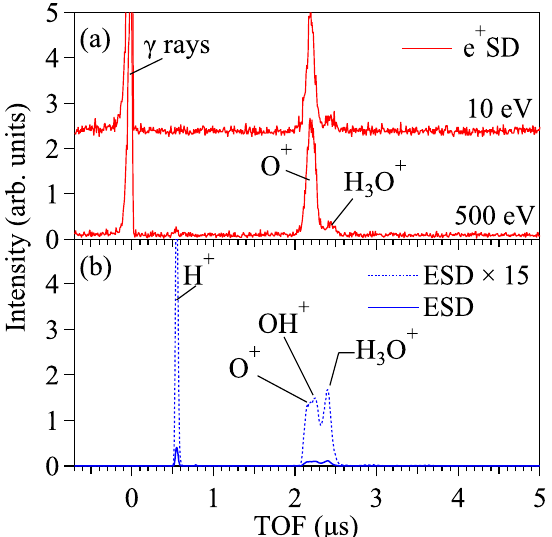
Figure 3. TOF spectra of the ions desorbed from water chemisorbed on a TiO 2 (110) surface caused by ( a ) positron bombardment at incident energies of 10 eV and 500 eV and TOF spectrum ( b ) 500-eV electron beam bombardment. Each spectrum was normalised to the number of incident particles. The blue dashed line in ( b ) indicates ESD results enlarged by a factor of